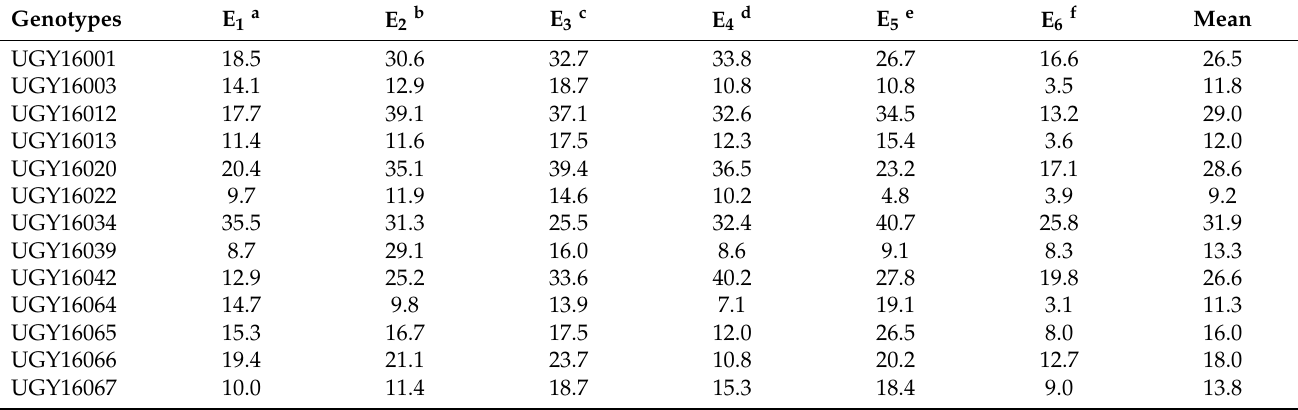
Arua 2021, with a mean total weight of yam of 11.5 kg/plot (Table 7). Table 7. Mean tuber yield (kg/plot) of 20 yam genotypes evaluated in six test environments in